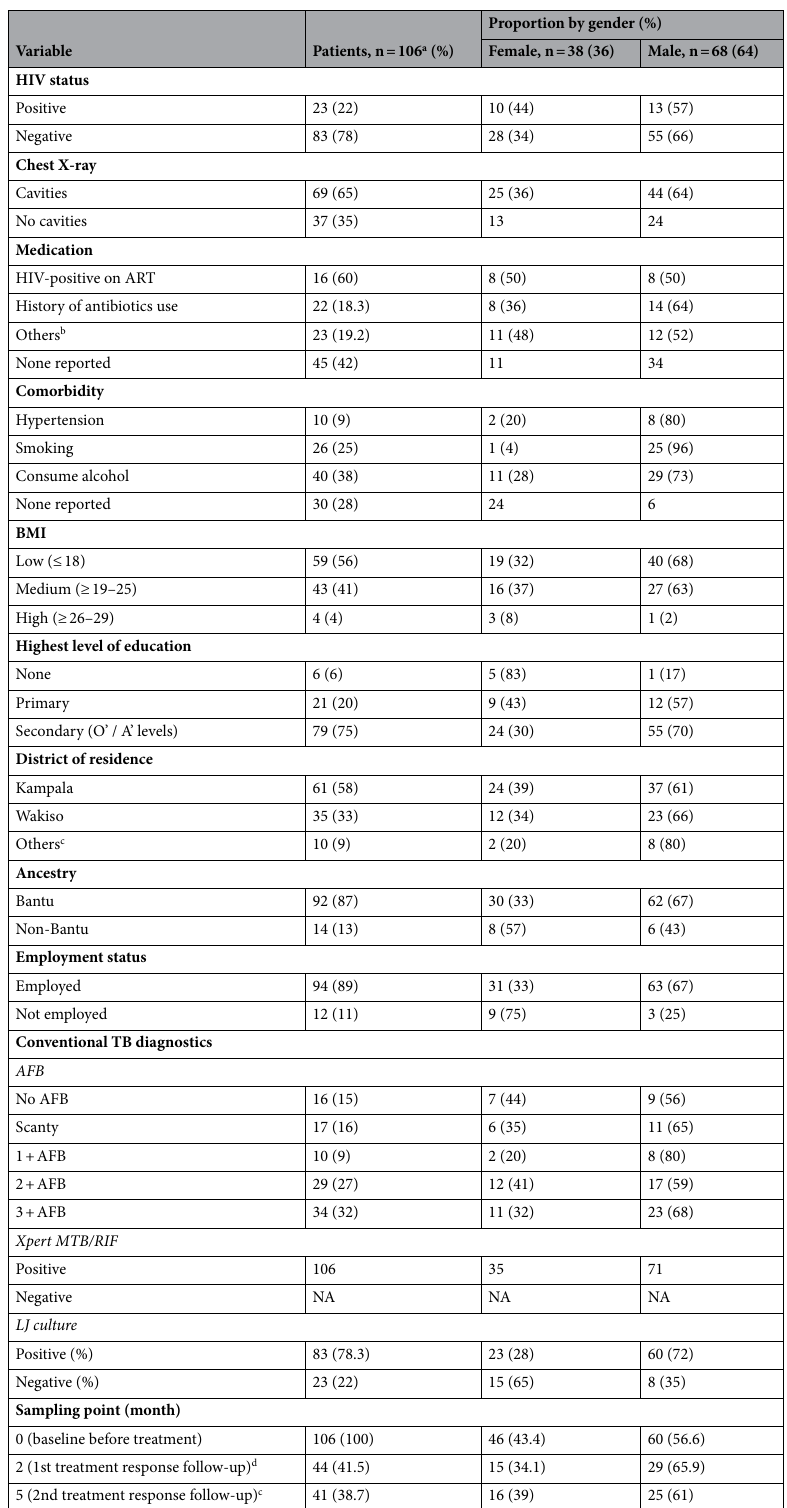
Table 1. Clinical and demographic characteristics of pulmonary TB patients enrolled. ART antiretroviral treatment, AFB acid fast bacilli, BMI body mass index, LJ Lowenstein-Jensen medium, NA not applicable. a Fourteen baseline samples were removed due to poor sequence quality leaving 106 patients (one sample per patient) with sequences that were analysed (120 − 14 = 106). b Refers to medicines other than antibiotics and antiretrovirals (ARVs). c Refers to participants staying in districts other than Kampala and Wakiso. d Of the 106 patients enrolled and sampled at baseline, the available samples from treatment response monitoring at months 2 and 5 represented 30 patients i.e., 44 and 41,